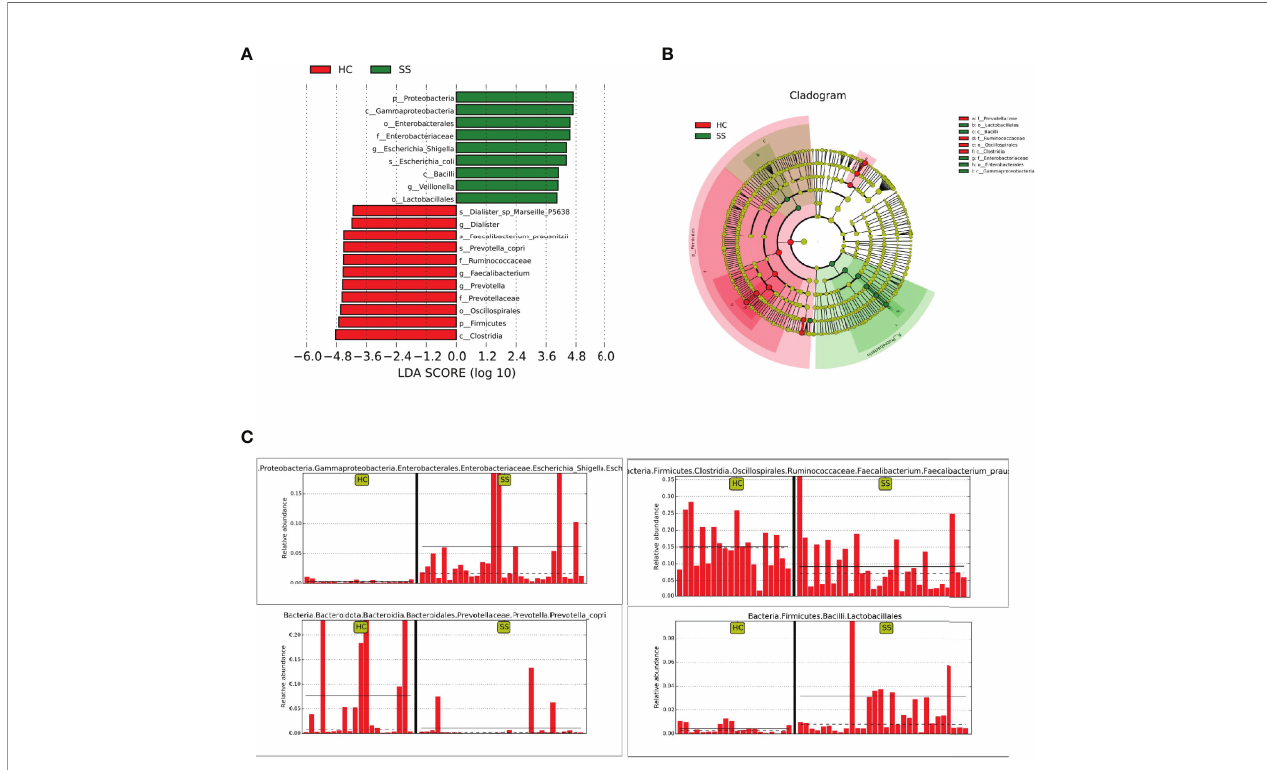
FIGURE 2 | LEfSe analysis. (A) Histogram of LDA value distribution. (B) Cladogram. (C) Comparison of the abundances of signi fi cantly different biomarkers ( Escherichia-Shigella, Lactobacillales, Faecalibacterium, Prevotella ) in pSS patients and